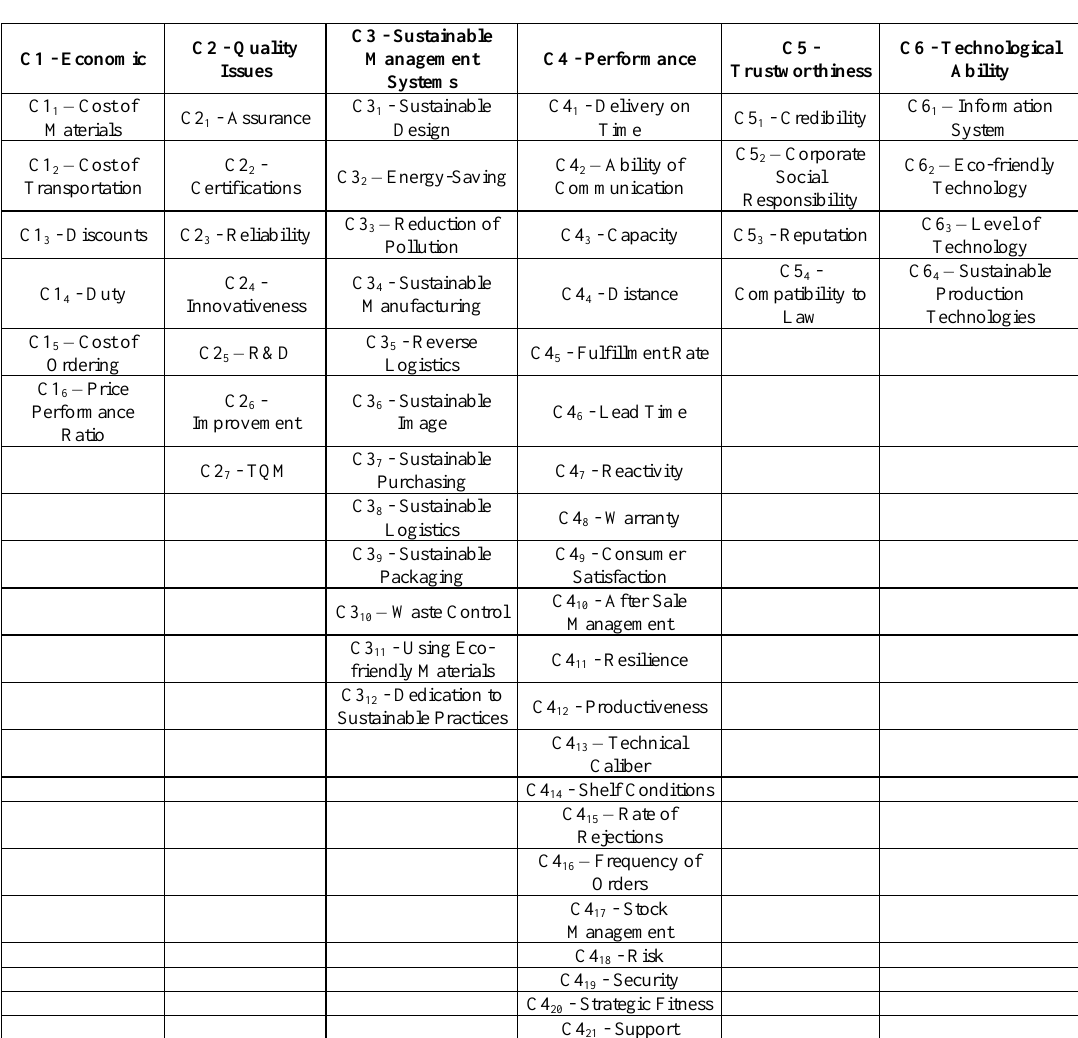
Table 1. Criteria